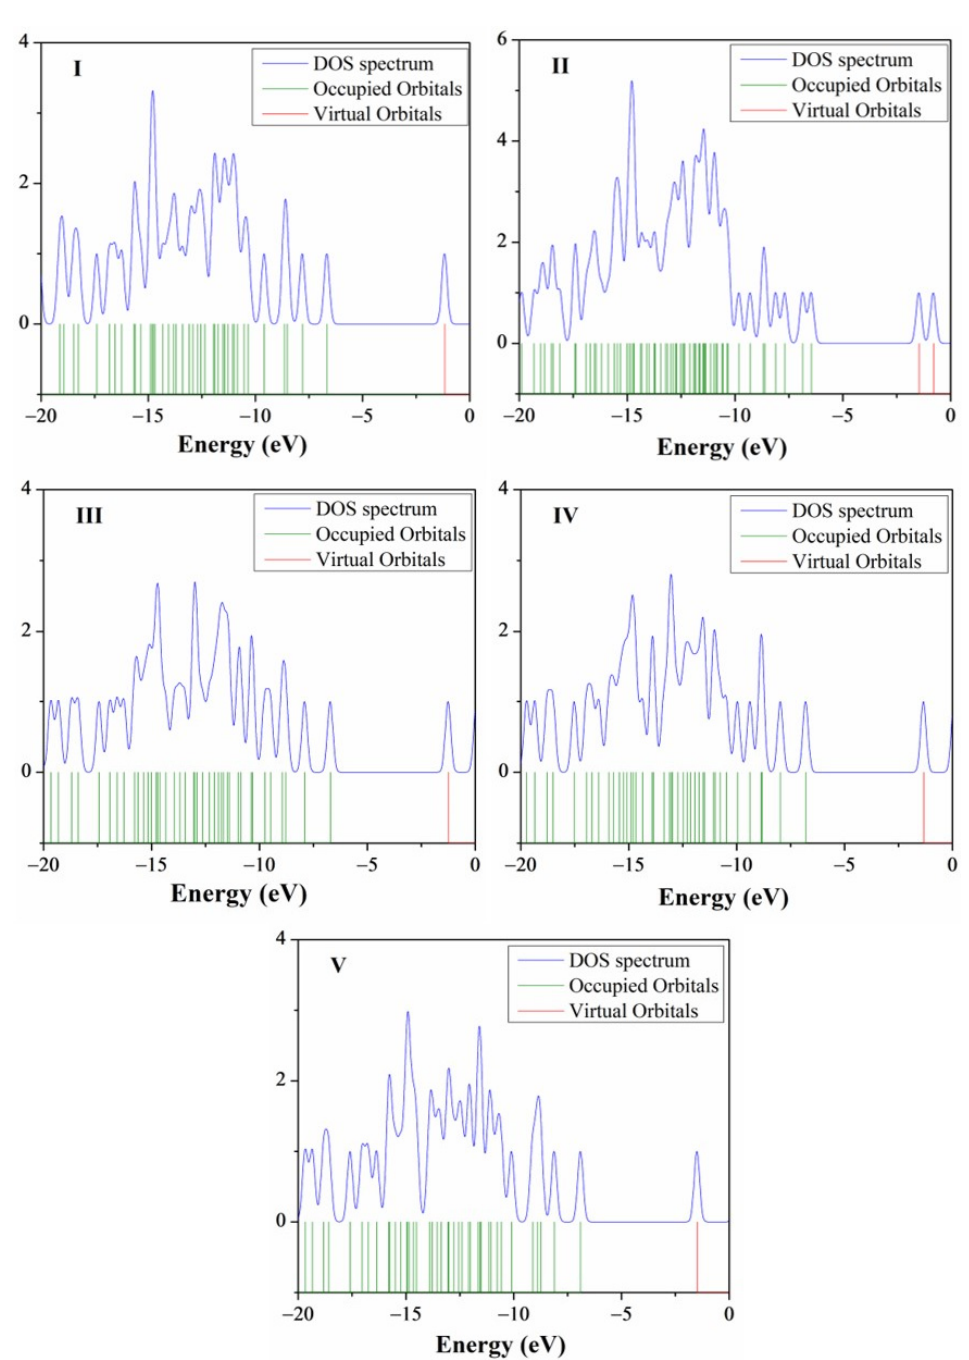
Figure 6. Density of states (DOS) diagrams of I – V compounds.